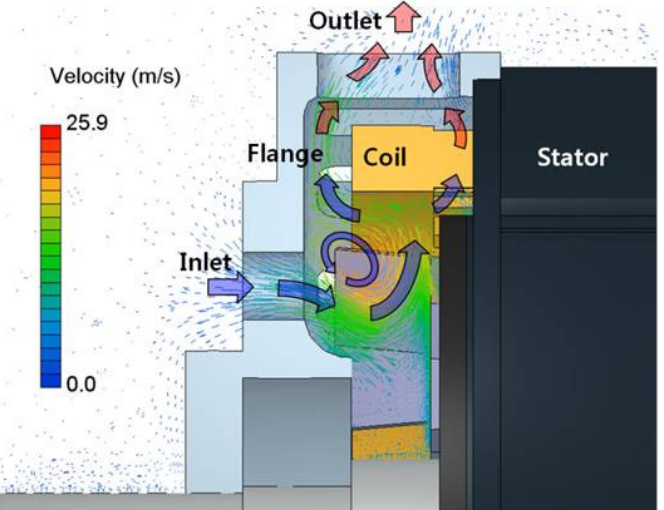
Figure 8. Internal flow of the ISG operating at an ambient temperature of 25  C and a motor speed of 4500 rpm.